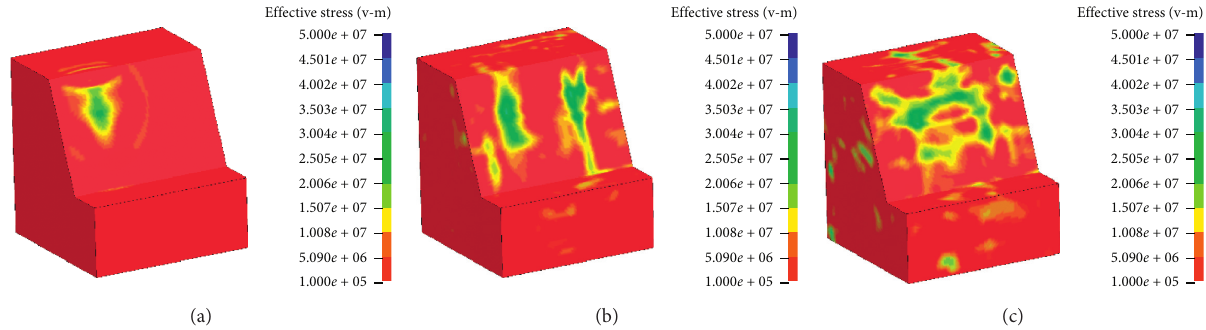
Figure 13: 15 m × 5.5m effective stress of the section between the front holes at different times. (a) t � 1.99ms. (b) t � 43.49ms. (c) t �